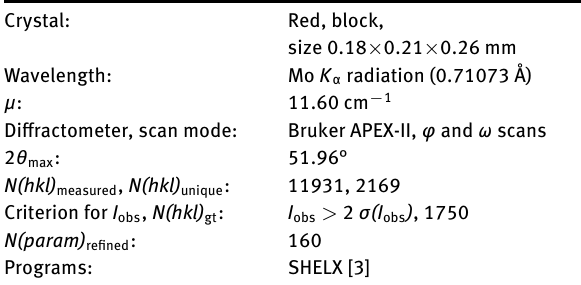
Table 2: Fractional atomic coordinates and isotropic or